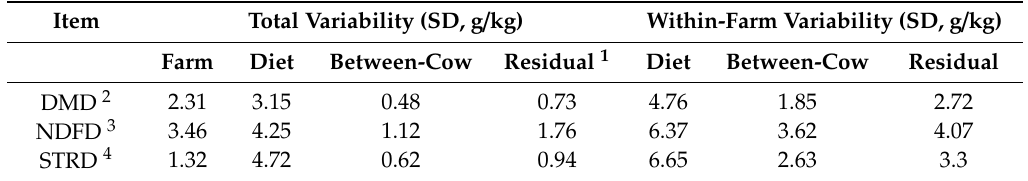
Table 6. Variance component estimates (SD) for digestion variables of lactating dairy cows when fed experimental diets.